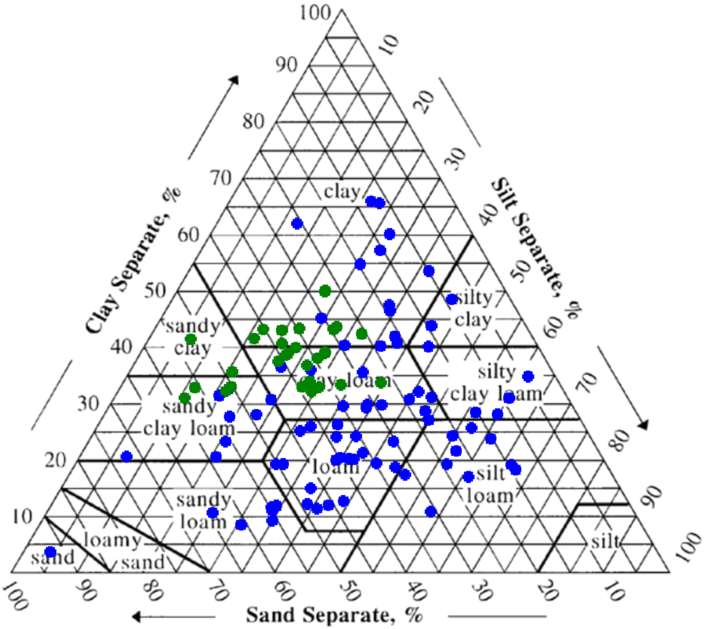
Distribution of soil samples (n = 117) inside the USDA soil texture triangle (Blue: SP1 data set 77 samples, Green: BR08 data set 37samples).